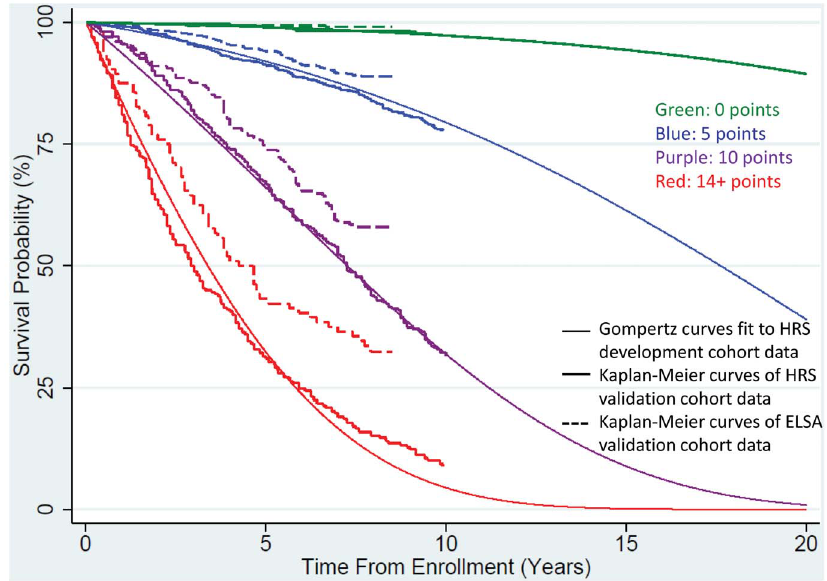
Figure 1. Life expectancy estimations using survival curve models and validation cohorts.